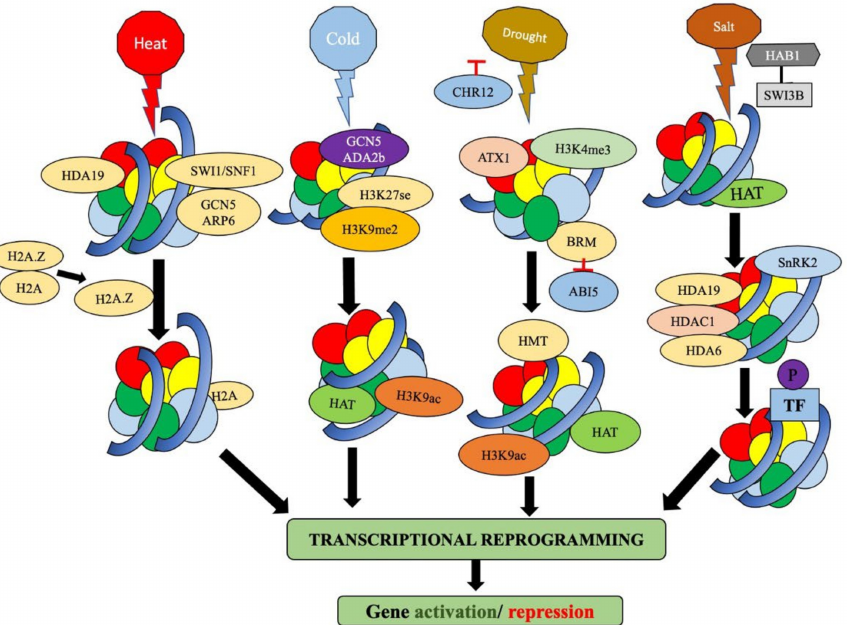
Figure 2. Chromatin dynamics under abiotic stresses such as heat, cold, drought and salinity in plants. During heat stress switching defective/sucrose nonfermenting (SWI1/SNF1) interacts with GCN5, ARP6 resulting in detachment of H2A.Z, facilitating downstream transcriptional reprograming. Transcriptional activator ADA2b, under cold stress, interacts with Arabidopsis GCN5 to boost up the HAT activity, which further results in transcriptional activation. During drought stress, the receptors first inactivate the Chromatin remodeling 12 (CHR12) and BRM. Inhibition in BRM activity further inhibits ABI5, which triggers ABA biosynthesis. Under excess saline conditions HAB1 and SWI3B cannot interact and bind with each other, leading to the activation of SNF1-related kinase (SnRK2) and subsequent phosphorylation of transcription factors leading to gene